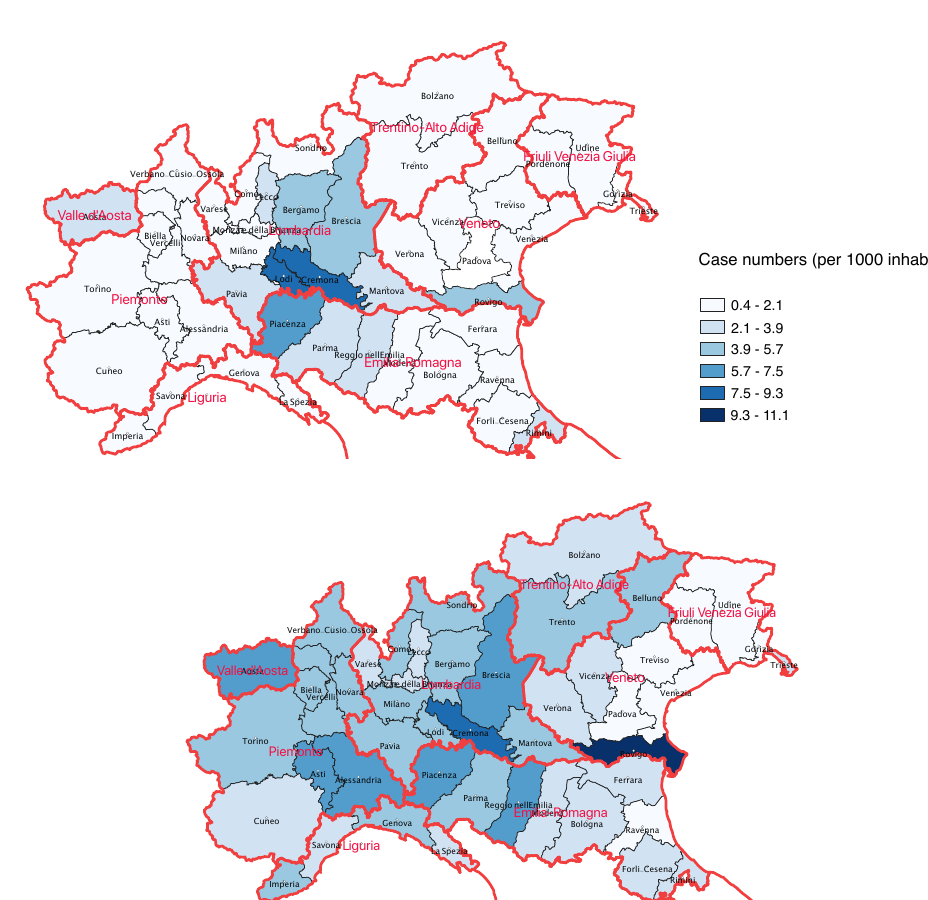
Figure 1. Total number of cases recorded per province corrected by 1000 inhabitants. Top panel : Pre-lockdown period. Bottom panel : Post-lockdown period.